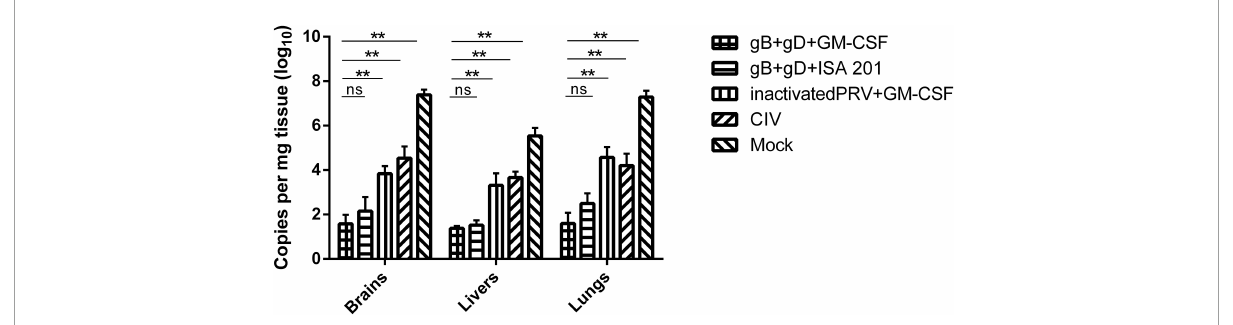
FIGURE6 Quantitation of PRV genome in rabbits tissues. PRV DNA was quantified in rabbit tissues using qPCR. PRV loads were shown as copies per mg of tissue. Data are representative of three independent experiments (error bars represent SD ). Significance is presented as ** p < 0.01.